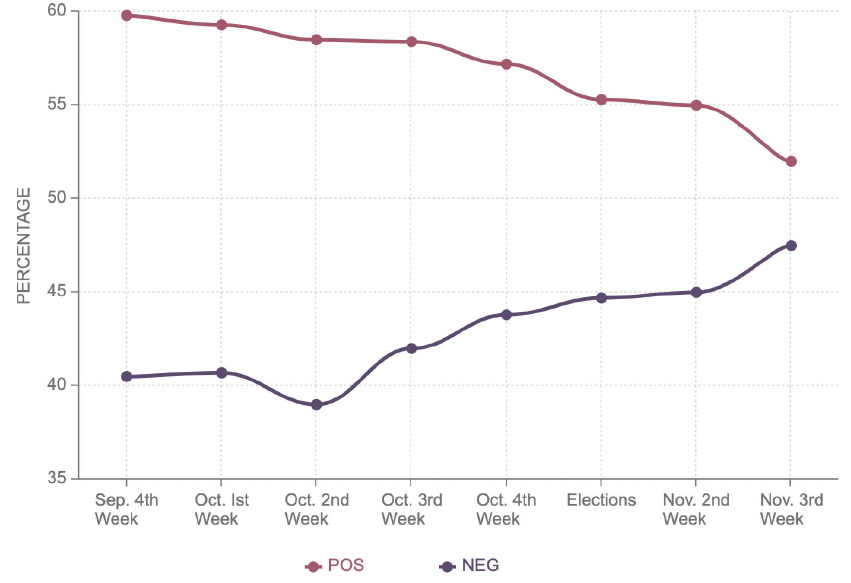
Figure 10. Graphs of positive and negative sentiments of Donald Trump in